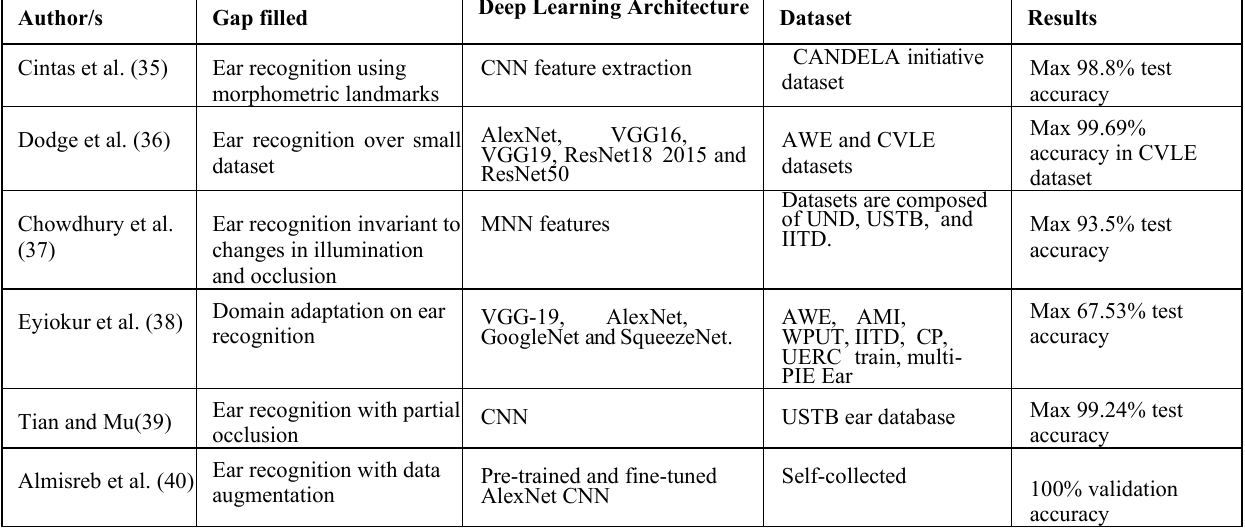
Table 2. Important works on Ear based identification using deep learning.